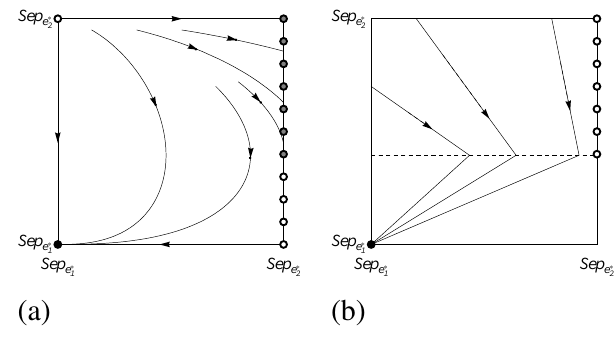
Figure 8. Phase portraits for the game in Table 2 limited to the sending and receiving strategies Sep and Sep for (a) the replicator dynamic and (b) the best response dynamic. e ∗ e ∗ 1 2 The horizontal direction shows the sending population and the vertical direction shows the receiving. Black, grey, and white dots indicate asymptotically stable, neutrally stable, and unstable rest points respectively.